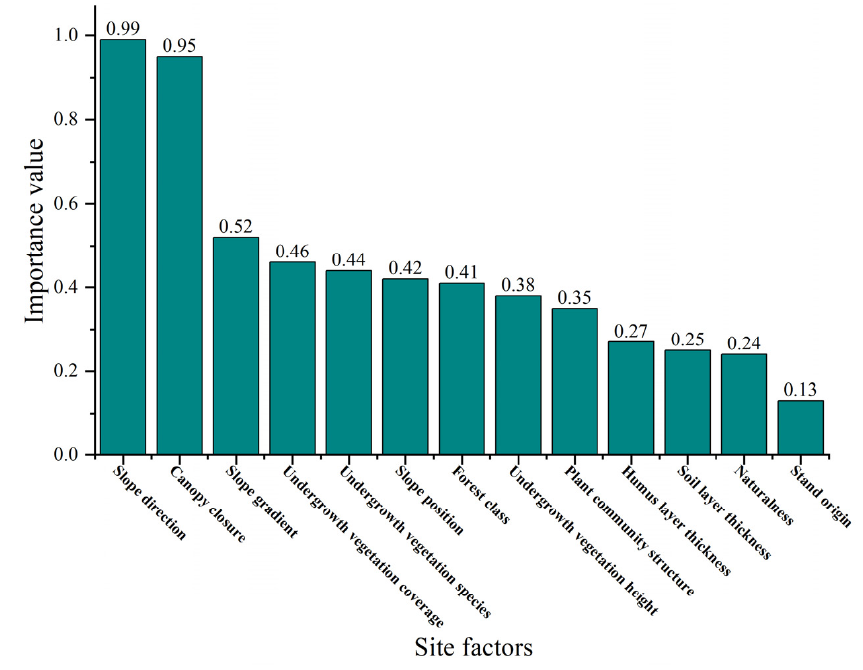
Figure 8. The importance ranking of the site